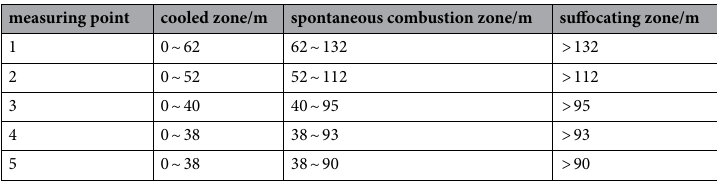
measuring point